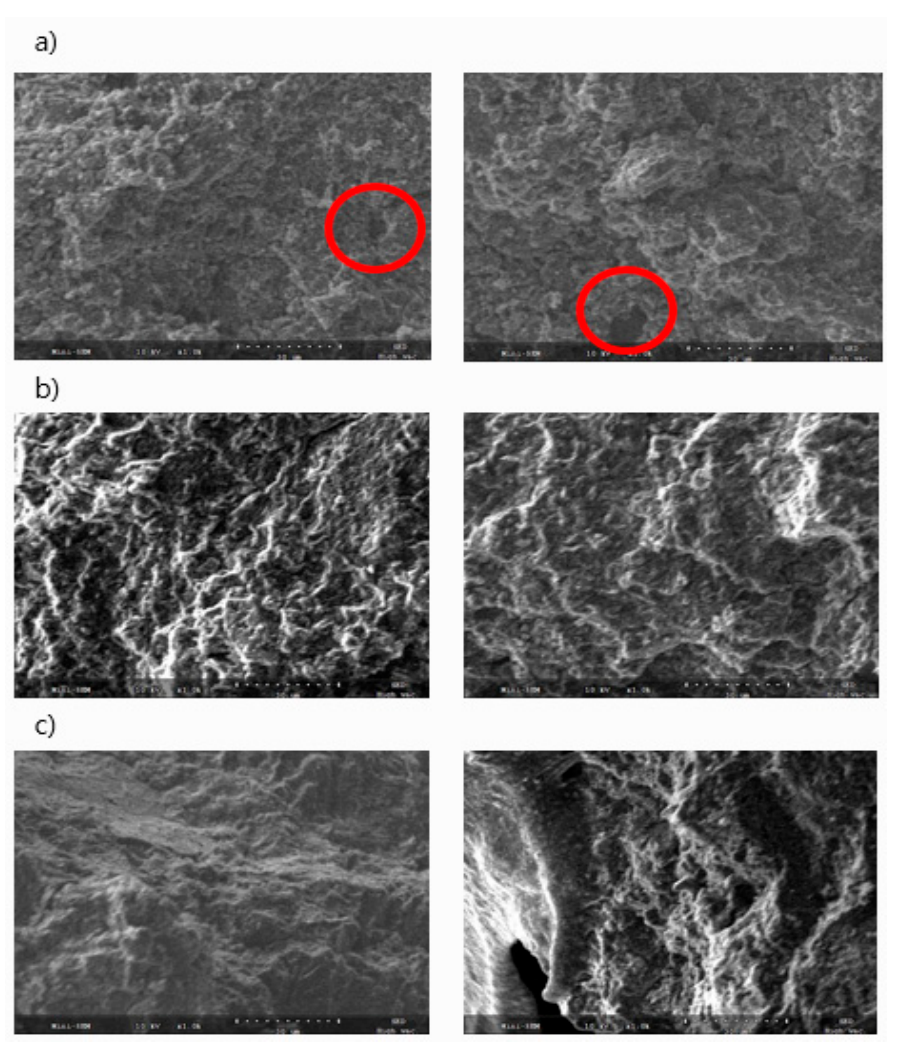
Figure 6. SEM image of high-density carbon blocks ( a ) CB-N10A0, ( b ) CB-N7A3, ( c ) CB-N0A10. Swelling occurred, and the microstructure was unstable in the cross-section when the sample was manufactured only in a nitrogen atmosphere. When considered in relation to the mechanical properties listed in Table 5, this phenomenon is judged to be due to the effect of oxygen during heat treatment. The postulated effect of air during the manufacture of binderless cokes is shown schematically in Figure 7. When only nitrogen is supplied during heat treatment to produce a binderless coke, a large amount of volatile matter remains, and when carbonized, the volatile matter rapidly escapes, and pores are formed inside the carbon block, which causes swelling. On the other hand, when air is allowed to flow, oxygen in the air causes a cross-linking reaction, reducing the amount of low molecular weight volatile matter and generating functional groups, such as hydroxyl, carbonyl, and carboxyl groups, which are advantageous for sintering. The carbon block will consequently have a more precise structure. In addition, an appropriate air ratio increases the β -resin content and suppresses the swelling phenomenon after carbonization, enabling the production of high-density, high-strength carbon